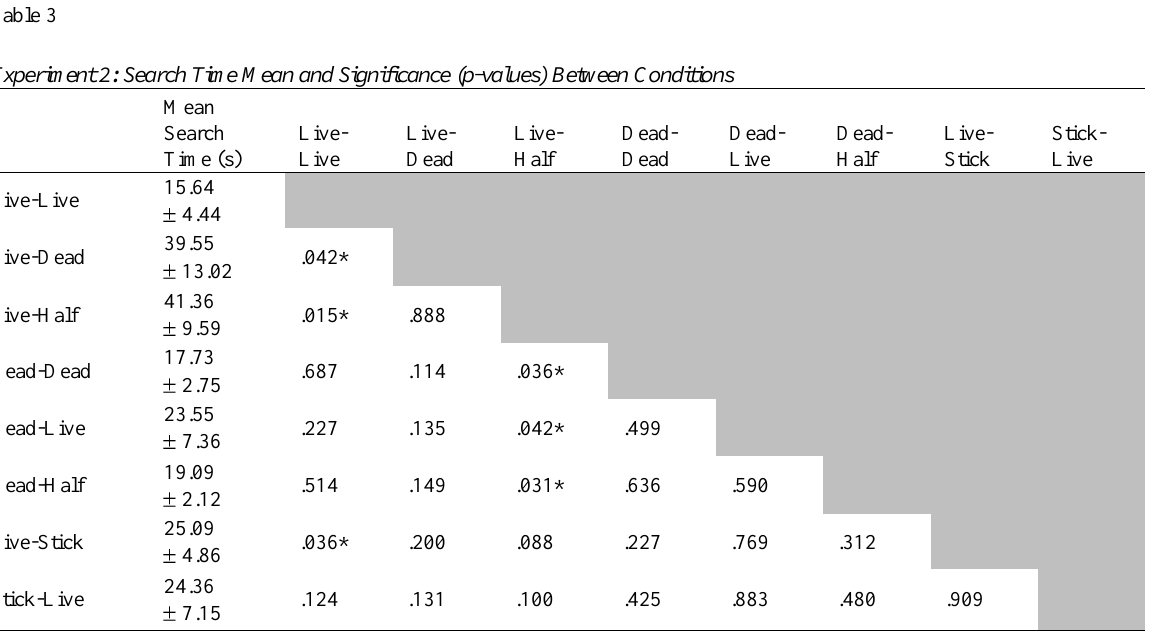
Experiment 2: Search Time Mean and Significance (p-values) Between Conditions